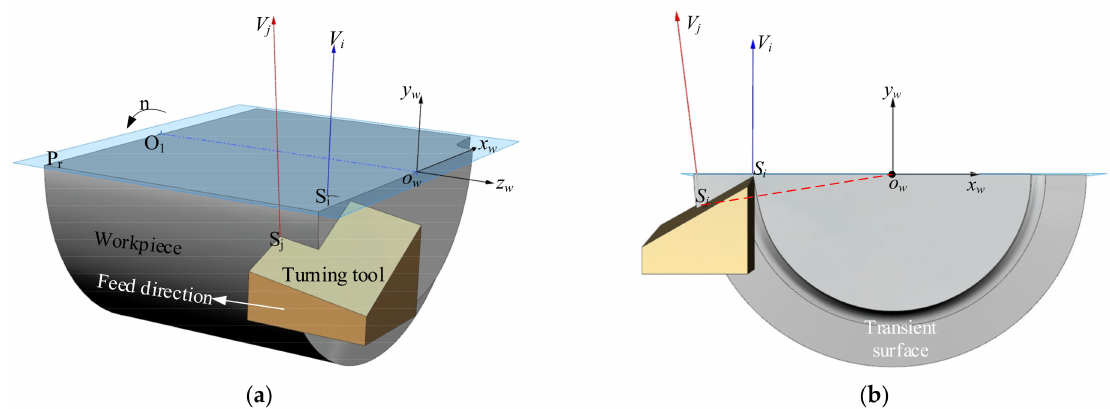
Figure 4. Actual cutting velocity direction along the cutting edge; ( a ) ISO view; ( b ) Z w view.